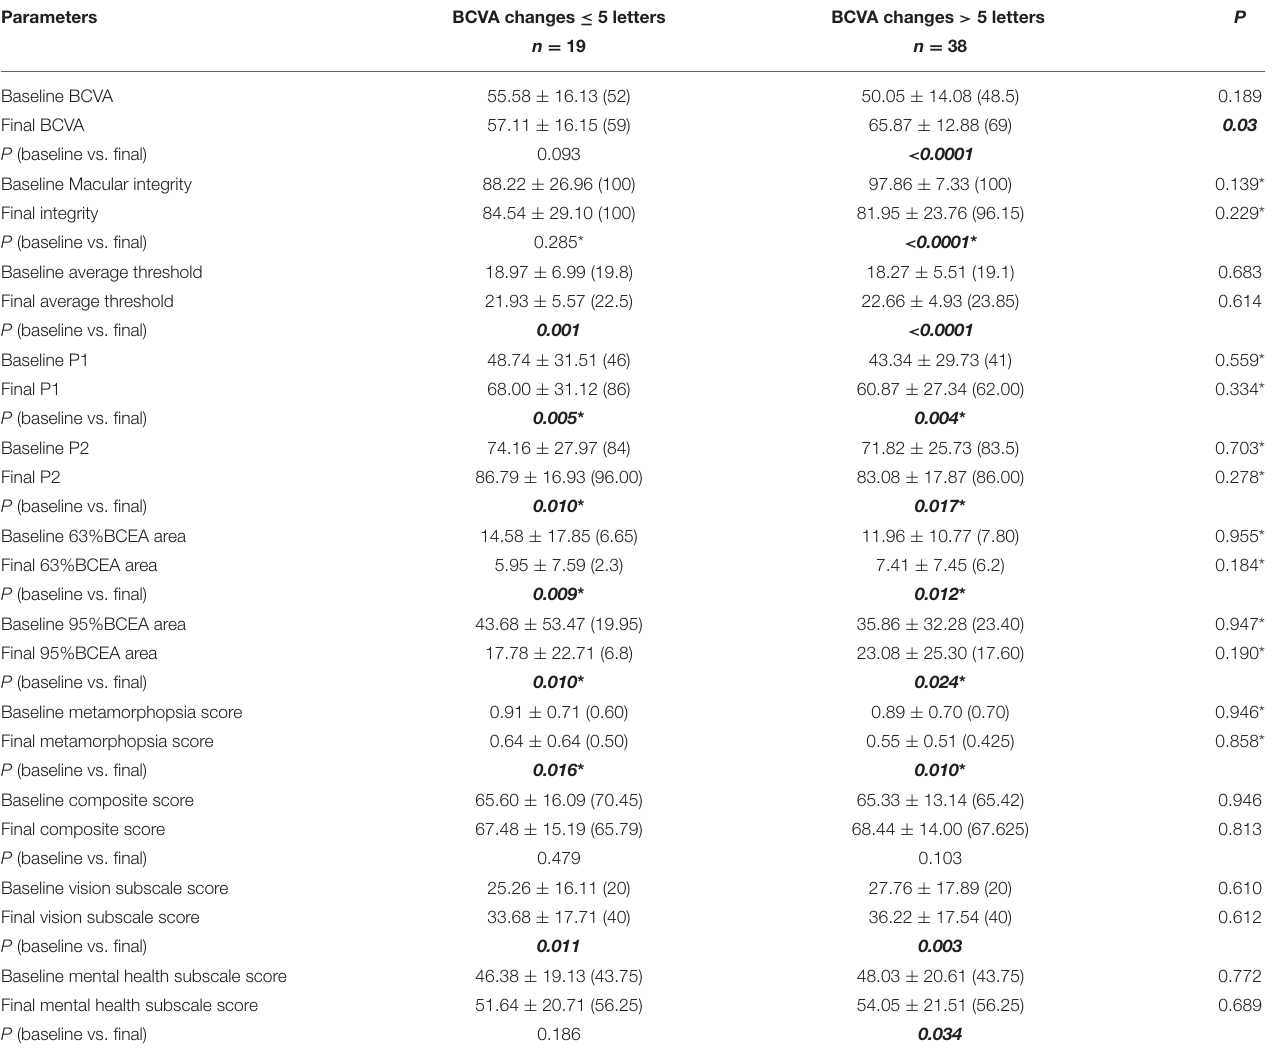
TABLE 4 | Visual function and VR-QoL parameters in BCVA improved subgroup and BCVA sustained